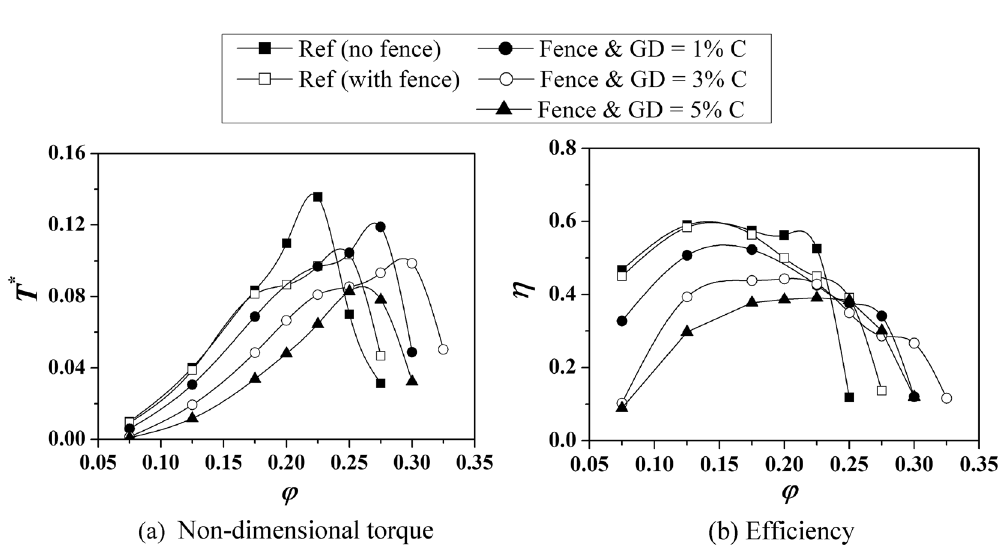
Figure 8. Comparison of different cases of the combined SF-CG case with two reference